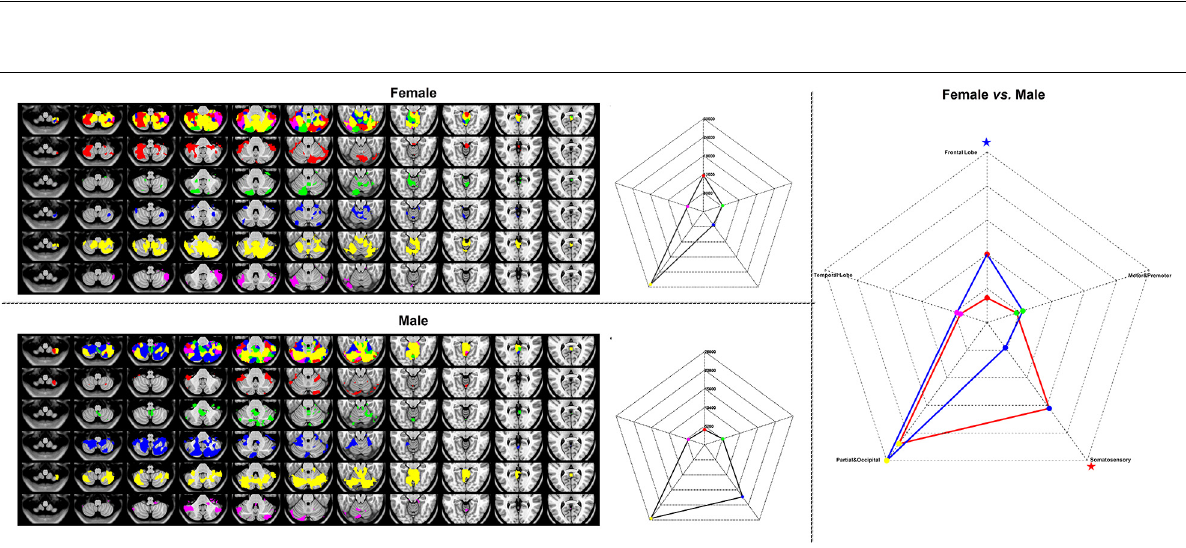
FIGURE 7 | The results of WTA-CSSCN mode. Red, frontal lobe; green, motor and premotor; blue, somatosensory; yellow, parietal and occipital; and violet, temporal lobe. The red star represented the female group > male group, and the blue star represented the male group < female